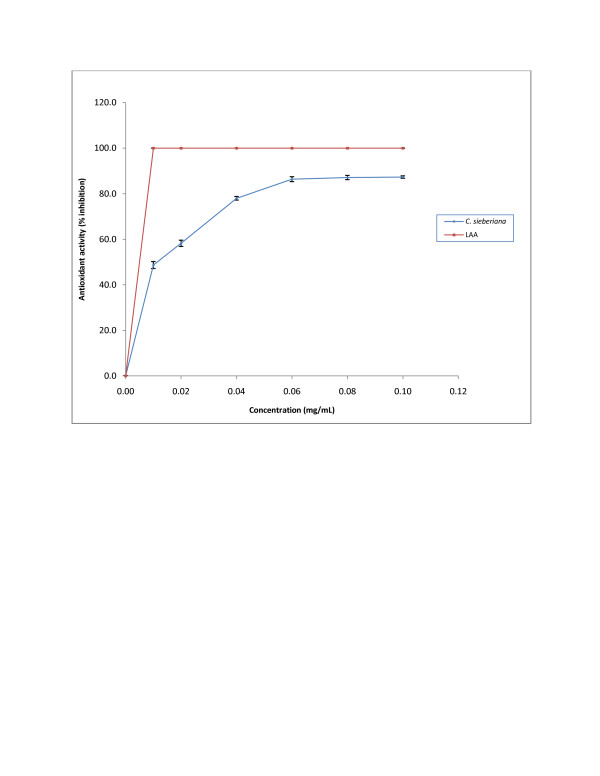
Antioxidant activity ofC. sieberianaroots bark extract against linoleic acid peroxidation induced by haemoglobin. L-ascorbic acid (LAA) was used as a reference compound. Results are means ± SEM of n = 3.